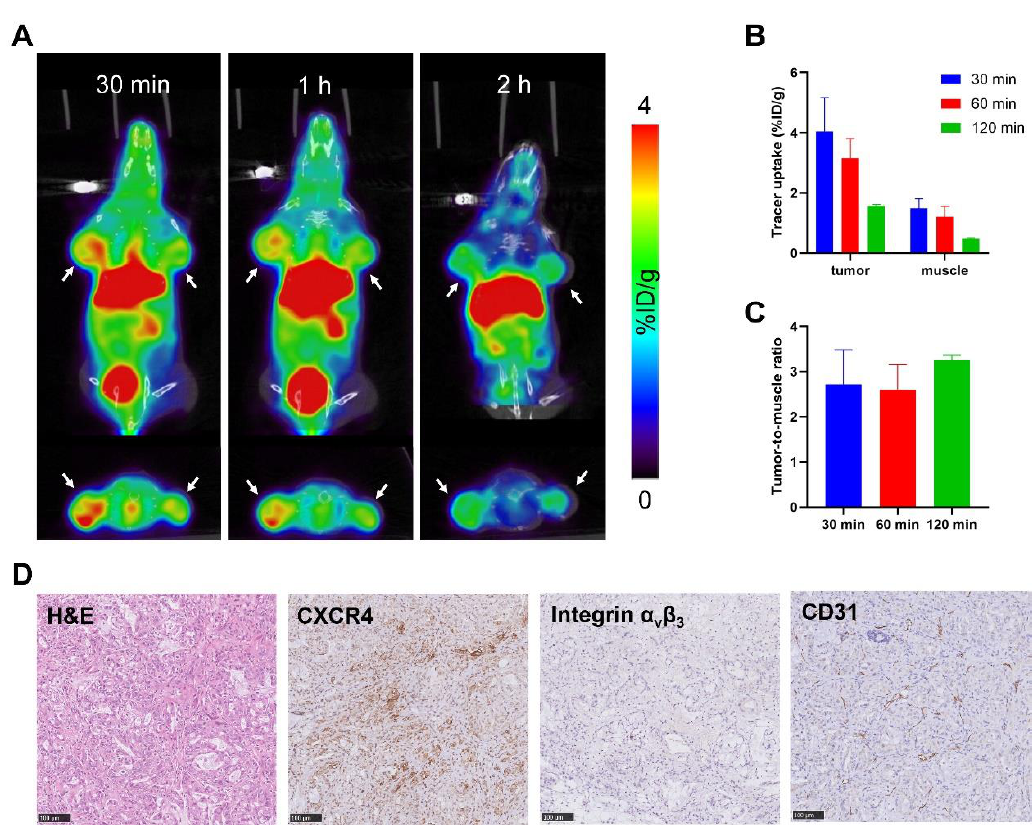
Figure 6. PET/CT scan and immunohistochemistry assay in pancreatic cancer-PDX models. ( A ) Rep- resentative static PET/CT images of pancreatic cancer-PDX models at 30 min, 1 h, and 2 h p.i. of 68 Ga-yG5-RGD (each 5.55 – 7.4 MBq). Arrows indicate the location of tumors, n = 4. ( B ) Tracer uptakes in tumors and muscles determined by quantitative ROI analysis of PET/CT images. ( C ) Tumor-to- muscle ratios. ( D ) Immunohistochemistry assay of CXCR4, integrin α v β 3 and CD31 in PDX-tumors (×200). Scale bar = 100 μm.